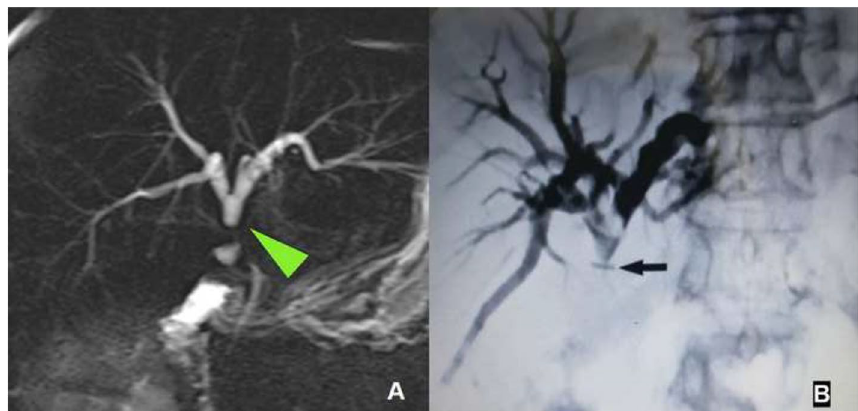
Fig. 5 3D-MRCP ( a ) post-cholecystectomy showing abrupt arrest of the CHD about 1.5 cm distal to the biliary carina “green arrowhead” with mild intra-hepatic biliary backpressure changes. Strasberg Type E2; Bismuth-Corlette Type 2 bile duct injury/ligation. PTC ( b ) is done 1 week later, showing a surgical clip “black arrow” occluding the common hepatic duct just below the confluence, confirming bile duct ligation with moderate intra-hepatic biliary radicles